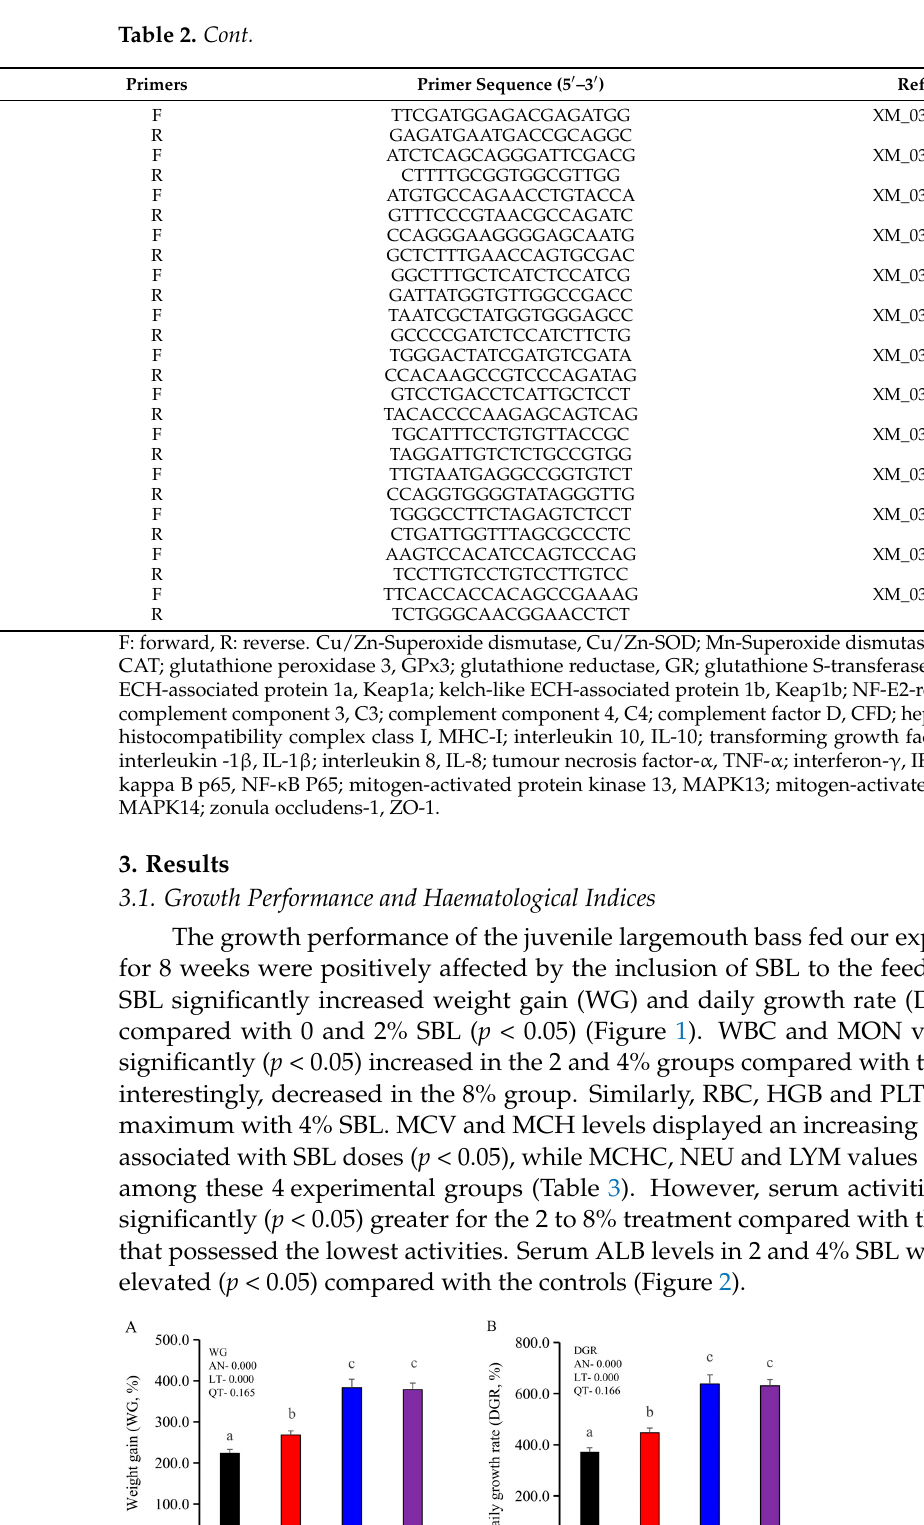
Figure 2. E ff ect of dietary soybean lecithin on serum albumin (ALB) contents ( A ) and alkaline phos- phatase (ALP) activities ( B ) of juvenile largemouth bass. Bars with di ff erent le tt ers indicate signi fi - cant di ff erences ( p < 0.05), while that with the same le tt er or no le tt er superscripts indicate no signif- icant di ff erences ( p > 0.05), AN: ANOVA, LT: linear trend, QT: quadratic trend. 3.2. Antioxidant and Oxidant Analyses 3.2.1. Antioxidant and Oxidant Parameters in the Liver Antioxidative indices in the fi sh also signi fi cantly di ff ered among these test groups. Activities of CAT and GPx were signi fi cantly higher in the 4% SBL groups compared with these indices in other three groups ( p < 0.05). In contrast, MDA contents notably declined with SBL supplementation from 2% to 8% and was the lowest in the 4 and 8% groups ( p < 0.05). T-AOC, GST activities and GSH levels were signi fi cantly higher in liver samples of the 4 and 8% groups ( p < 0.05). T-SOD and GR activities were enhanced in the 2% group ( p < 0.05) and then plateaued. However, Keap1a levels were signi fi cantly reduced and sig- ni fi cantly negatively correlated with SBL doses ( p < 0.05) (Table 4). Table 4. E ff ects of dietary soybean lecithin on the antioxidative and oxidative indices in the liver of largemouth bass. Lecithin ( % ) in Diets Parameters